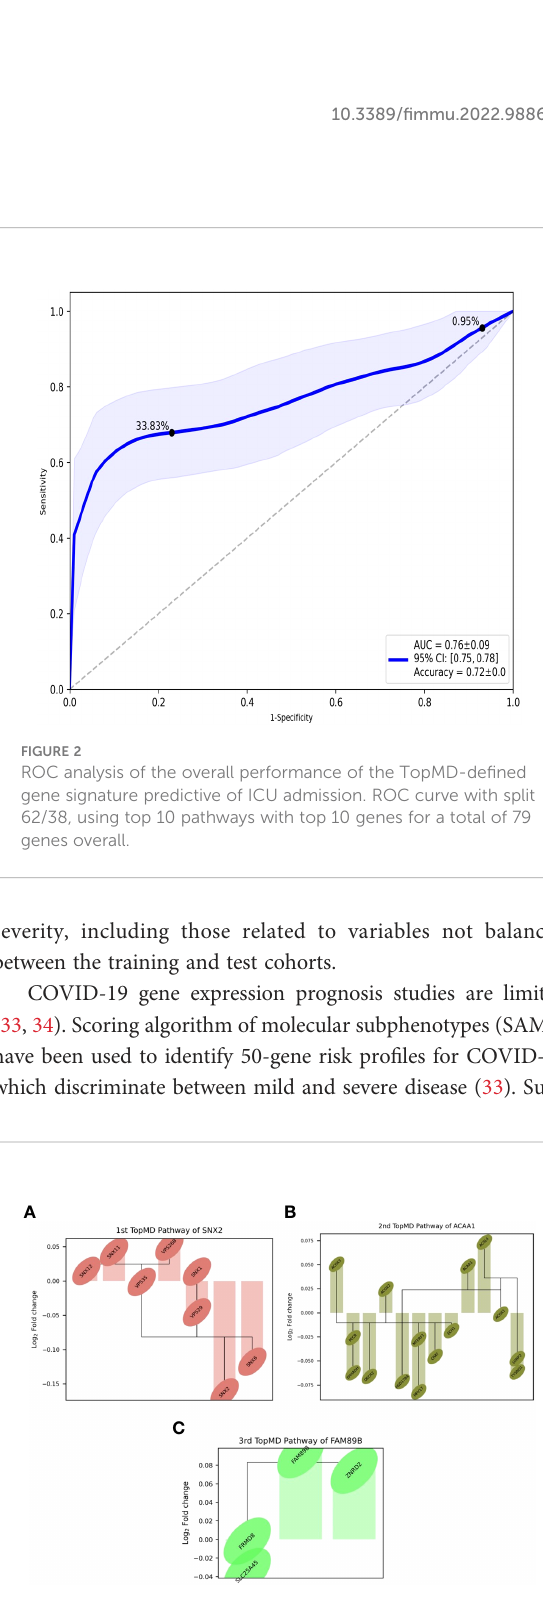
FIGURE 3 Differential expression of top genes in the top 3 pathways between patients admitted to ICU and not admitted to ICU of the training set. Connections represent known gene interactions according to STRING-db. (A) SNX2 - controlling epidermal growth factor receptor (EGFR) presentation, (B) ACAA1-peak pathway, representing peroxisome proliferator-activated receptor alpha (PPAR- a ) signalling, (C) FAM89B-peak pathway, mediating transforming growth factor beta (TGF- b ) signalling. Pathways and genes identi fi ed by topological data analysis, TopMD.